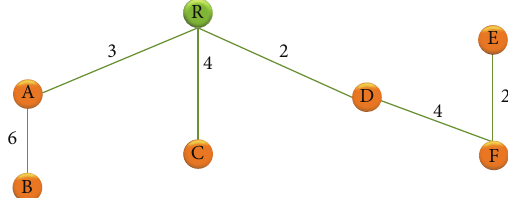
Figure 9: Optimal topology structure of the TAN.